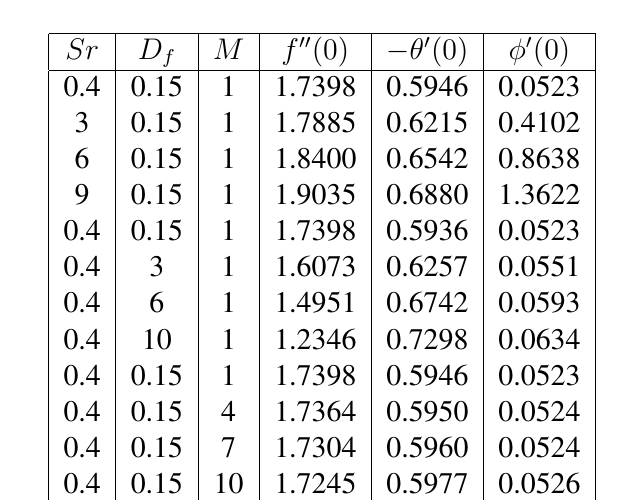
= 1 , λ = 0 . 1 , Da = 0 . 5 , Re = 400 , R = 0 . 5 , δ = 0 . 2 and 1 2